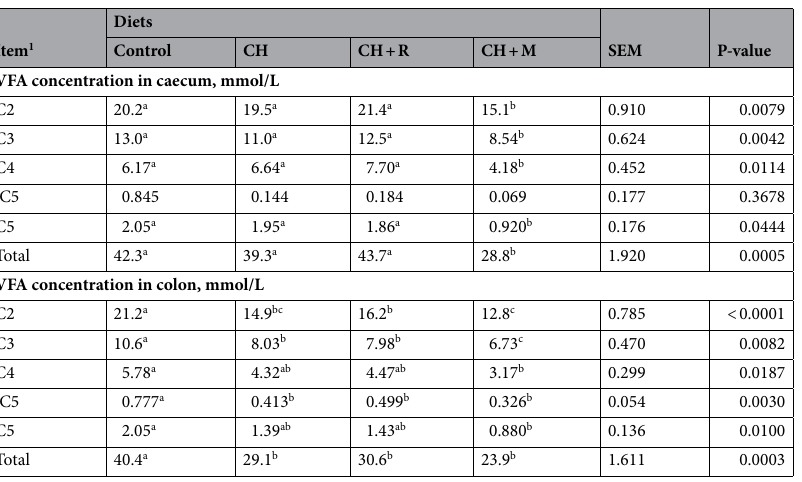
Table 4. Effect of diets on volatile fatty acids (VFA) concentration in caecum and colon of piglets. Control = control diet; CH = Chlorella vulgaris diet; CH + R = C. vulgaris diet supplemented with Rovabio® Excel AP; CH + M = C. vulgaris diet supplemented with a pre-selected enzymatic mixture. 1 C2, C3, C4, C5 and iC5 are acetic, propionic, butyric, valeric and isovaleric acids, respectively. a,b,c Values within a row with different superscripts differ significantly at P <